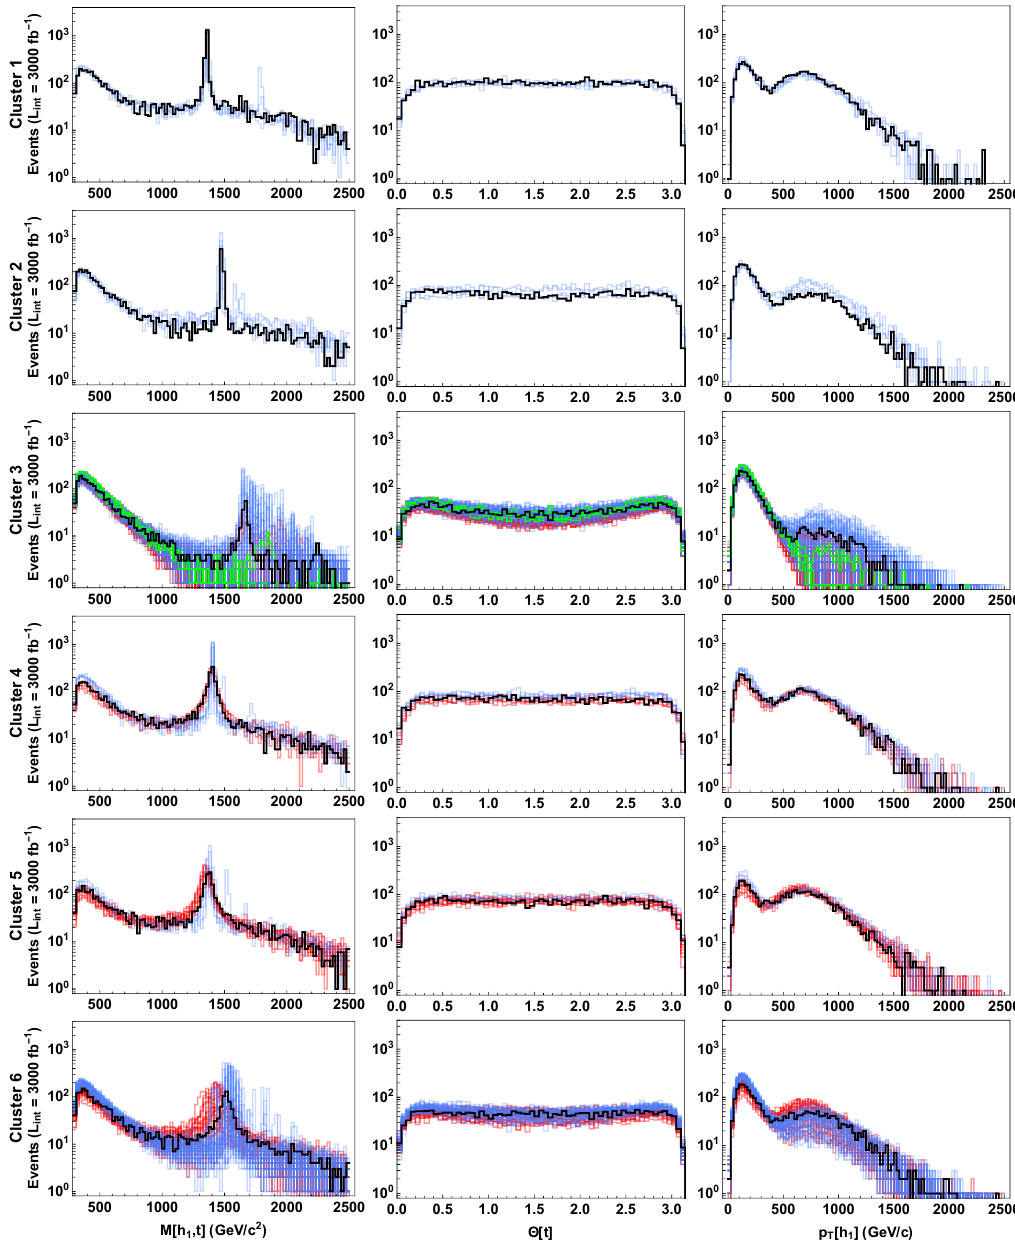
√ Figure 11 . Distributions at s = 14 TeV for the invariant mass of the pair composed by top and most energetic Higgs (first column), angular distribution of the top (second column) and transverse momenta of the most energetic Higgs, organized in clusters by similarity (clusters 1 through 6). Red and blue curves indicate respectively points in Regions I and II of the MCHM 5 , the benchmark point for each cluster is shown in black and the example points of table 1 are shown in green (cluster 3 contains P 2 , P 4 and P 5